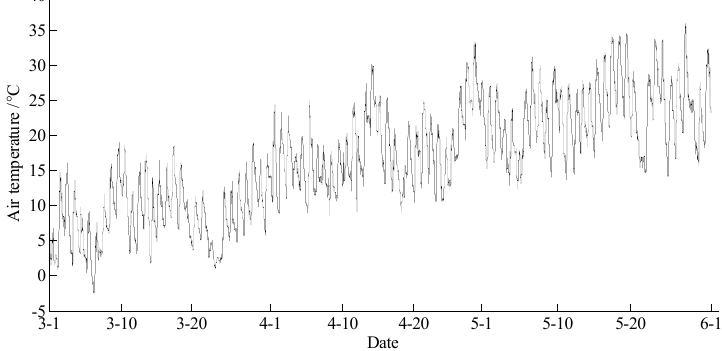
Figure 11. The curve of air temperature in Yan’er Ridge.